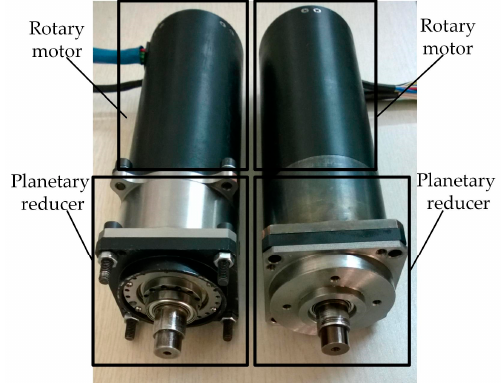
Figure 1. The driving component. Table 1. The major parameters of the rotary motor and planetary reducer.